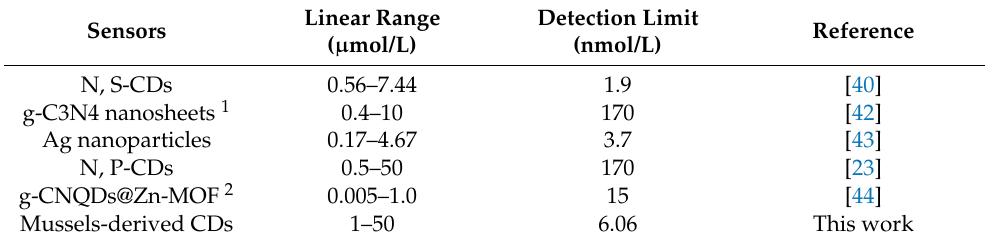
Table 1. Comparison of different sensors for the detection of riboflavin.